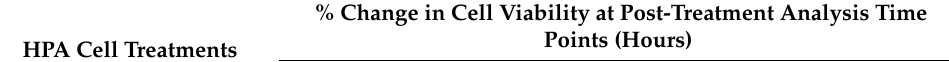
Table 4. Cell death induced by low-level laser treatment in HPA cells.